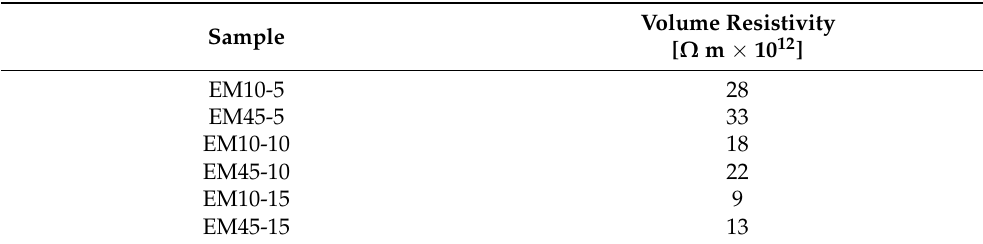
Table 3. Volume resistivity measured for the mica nanocomposites containing the highest amounts of mica